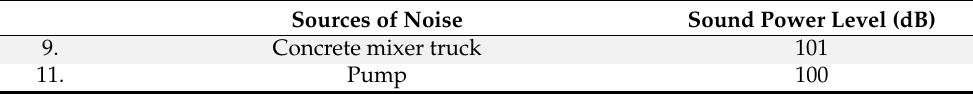
Table 17. Expected sources of construction